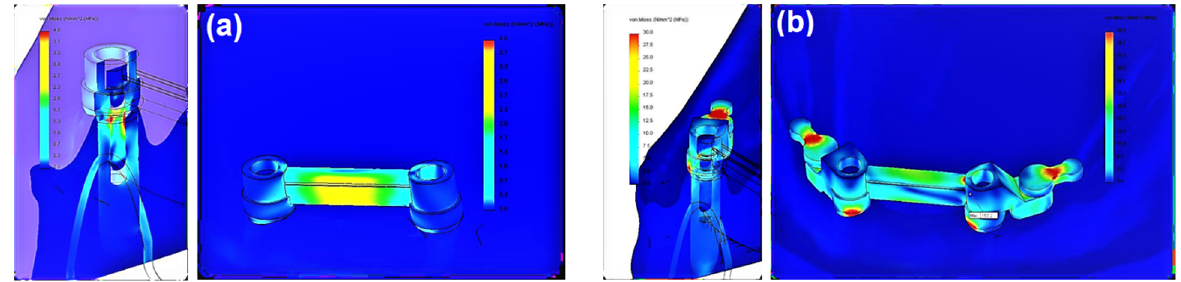
Figure 9. Average denture displacement in the first and second system. The greatest stress concentrate within the precision element and concern the bar. In the first system, bar stress ranges from 0.0020 to 27.552 MPa (Figure 10), obtained when a canine is loaded with a vertical force of 100 N. High values of maximum stresses when loading all teeth with a vertical force of 100 N are, however, focal, while the average values are definitely smaller (3.8260 MPa for an incisor, 3.1607 MPa for a canine, and 1.1483 MPa for a molar). Regardless of the force location, higher stresses occur for oblique forces. The largest bar stresses appear in the medial area, especially for the incisor and canine. For the